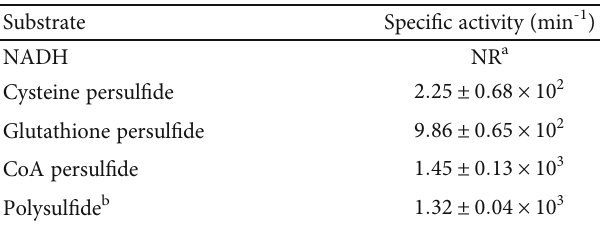
Table 3: Speci fi c activity of AfNpsr under anaerobic conditions at 70 °